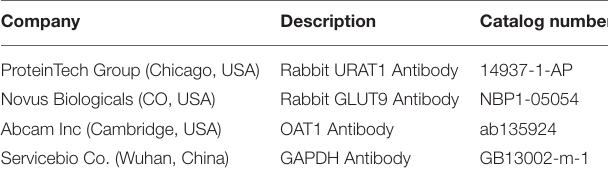
TABLE 2 | Antibodies for Western blotting